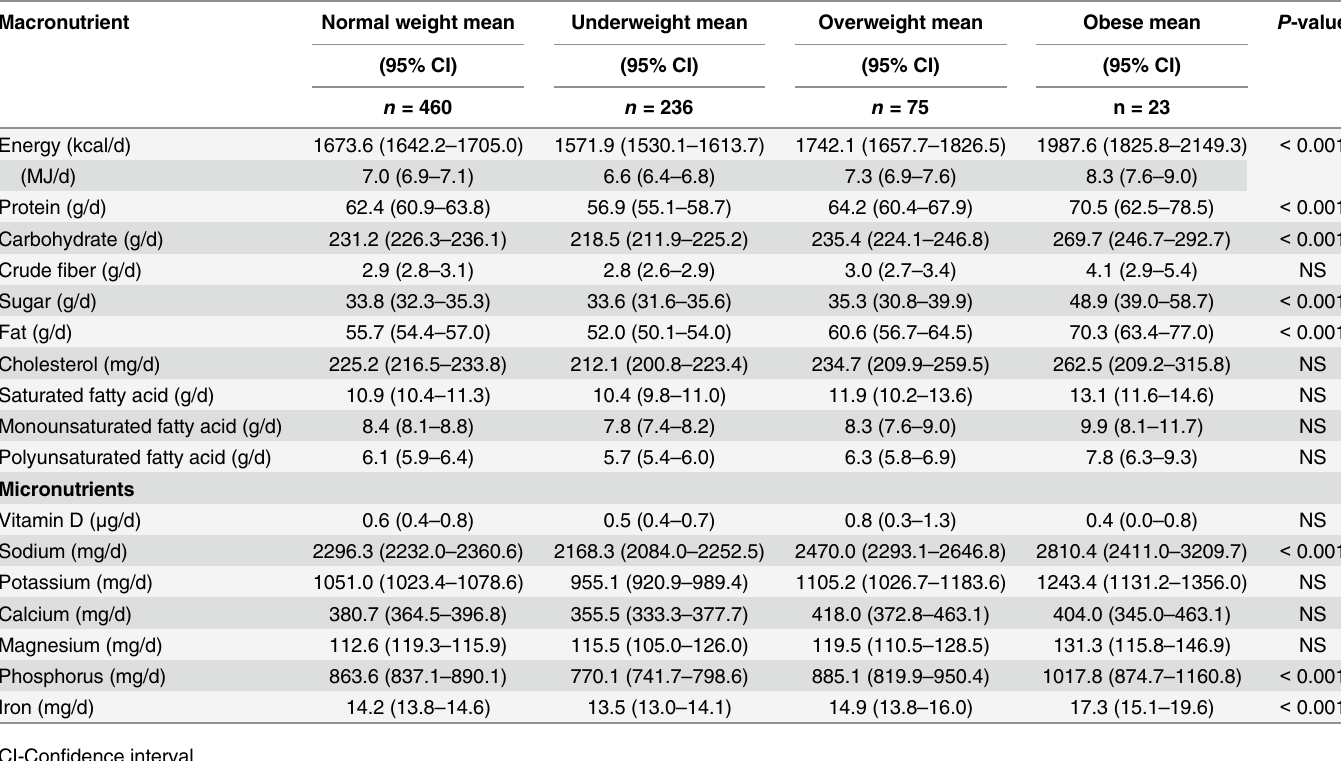
Table 4. 7-d nutrient intake for adolescents age 13 y attending secondary schools by body mass index.